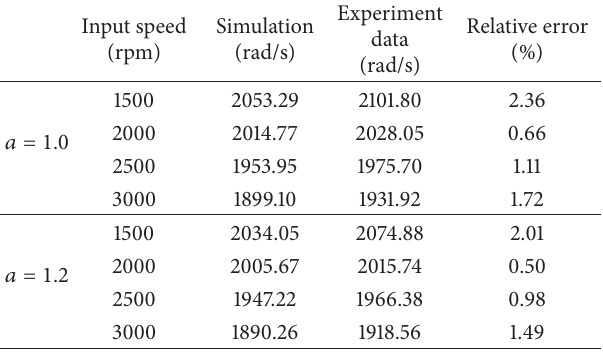
Table 6: Comparative analysis on the speed fluctuations of the driven